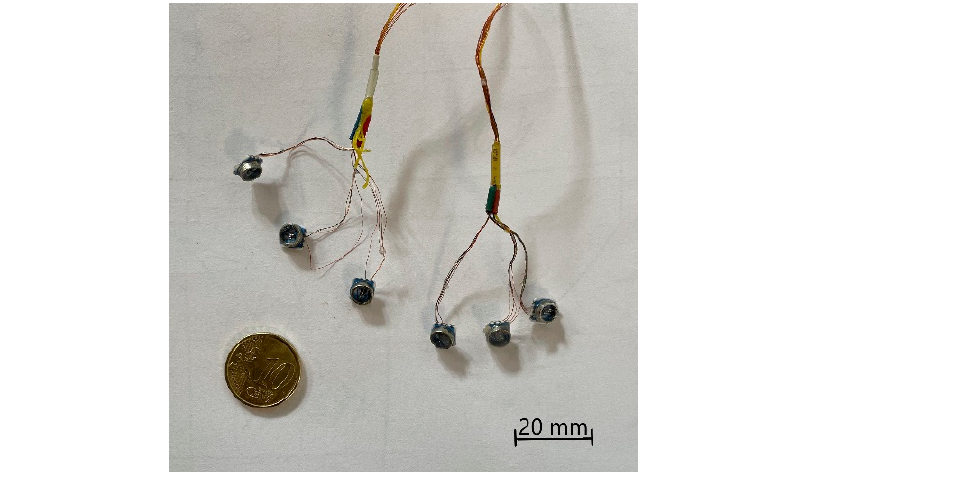
( c ) Figure 4. Casting procedure: ( a ) Result of the first cast, the upper part of the specimen is realized with a cavity to insert the sensors. ( b ) Sensor positioned inside the cavity; uncured silicone rubber is added to make the sensor adhering to the cured material. The upper cast is positioned for the final step. ( c ) Result after the casting, sensors are embedded, and their cables exit from a vertex of the specimen. 2.5. Pressure Sensor Uniaxial Test To verify the feasibility of using piezoresistive pressure sensors in our test probe, we decided to conduct a brief preliminary study on a single pressure sensor to evaluate its uniaxial response to external loads when embedded in a silicone rubber. To do so, we prepared a cylindrical specimen (diameter: 25 mm, height: 50 mm) with a pressure sensor embedded in its center. This cube was put inside a tensile testing machine and tested in cyclic compression and tension tests by applying a series of ten sine waves at 1 Hz fre- quency and 20% strain range. The aim of this pilot analysis was twofold: to verify if the pressure sensor was suitable for tensile measurements and to check its linearity. The prep- aration and calibration procedure of the uniaxial pressure sensor is shown in Figure 5.